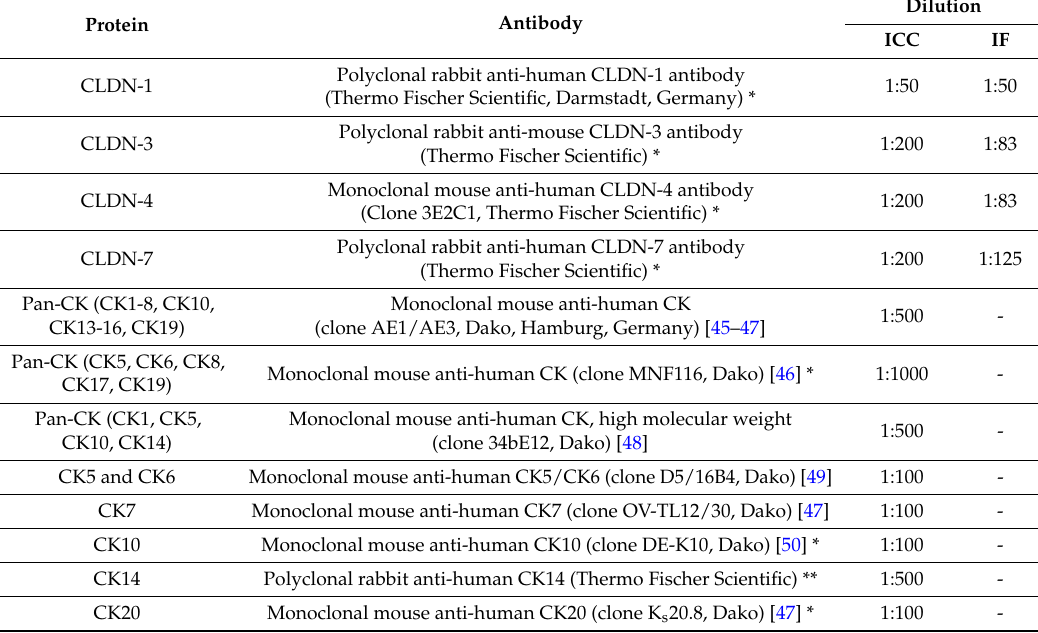
Table 5. List of antibodies used for immunocytochemistry (ICC) and immunofluorescence (IF). Staining pattern of all antibodies is identical to that described in the literature. “*” cross-reactivity with canine according to manufacturer’s information, “**” the canine KRT14 gene is a homolog of the human KRT14 gene (National Center for Biotechnology Information HomoloGene). Cross reactivity of the antibody is highly presumable as amino acid sequences of the human (NP_00517.2) and canine (NP_001240670.1) cytokeratin 14 reveal an identity of 97% (according to National Center for Biotechnology Protein Blast). Dilution Protein Antibody ICC IF Polyclonal rabbit anti-human CLDN-1 antibody CLDN-1 (Thermo Fischer Scientific, Darmstadt, Germany)